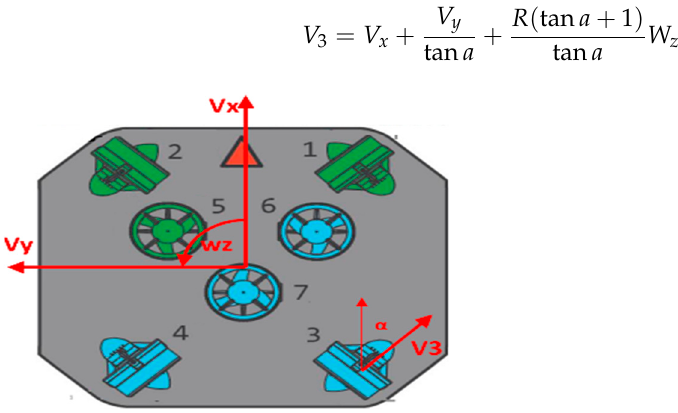
Figure 15. The distribution of the thrusters.